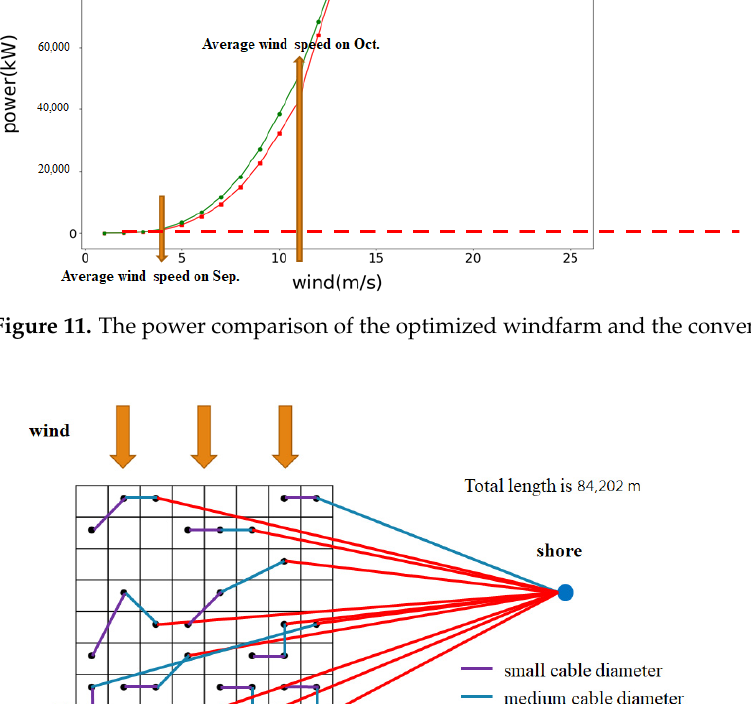
Figure 11. The power comparison of the optimized windfarm and the conventional windfarm.